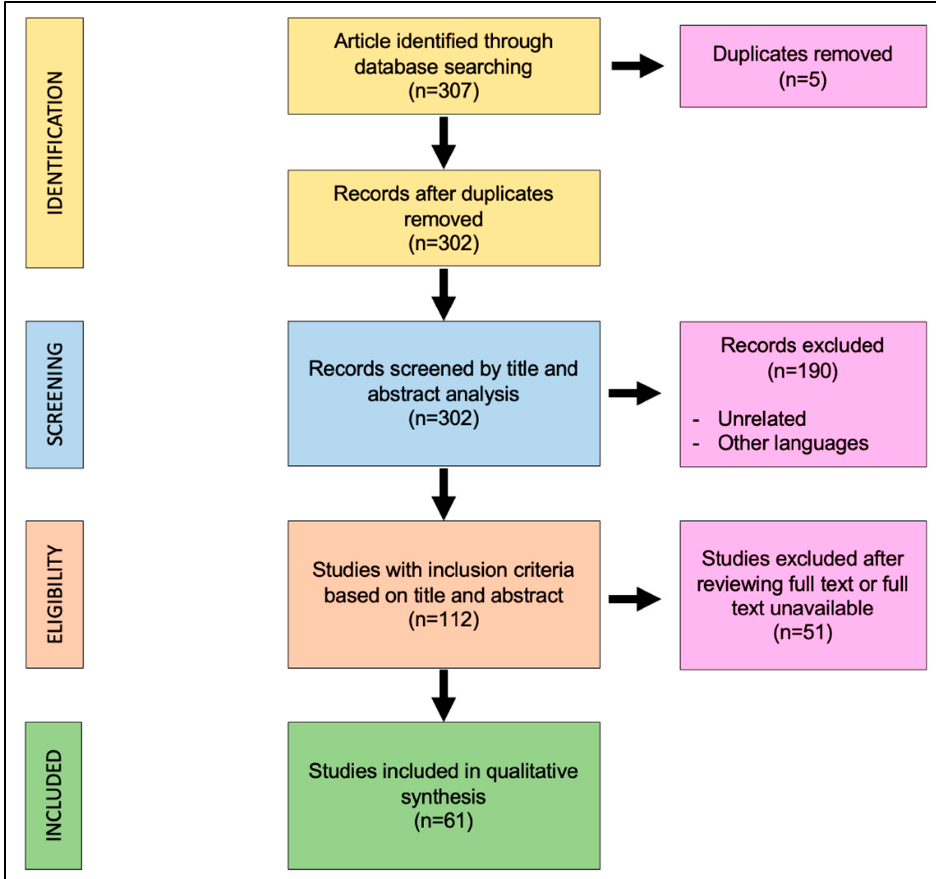
Figure 1. Preferred Reporting Items for Systematic Reviews and Meta-Analyses (PRISMA) diagram followed in this review. The diagram shows the information flow through the different phases of the review and illustrates the number of records that were identified and included.